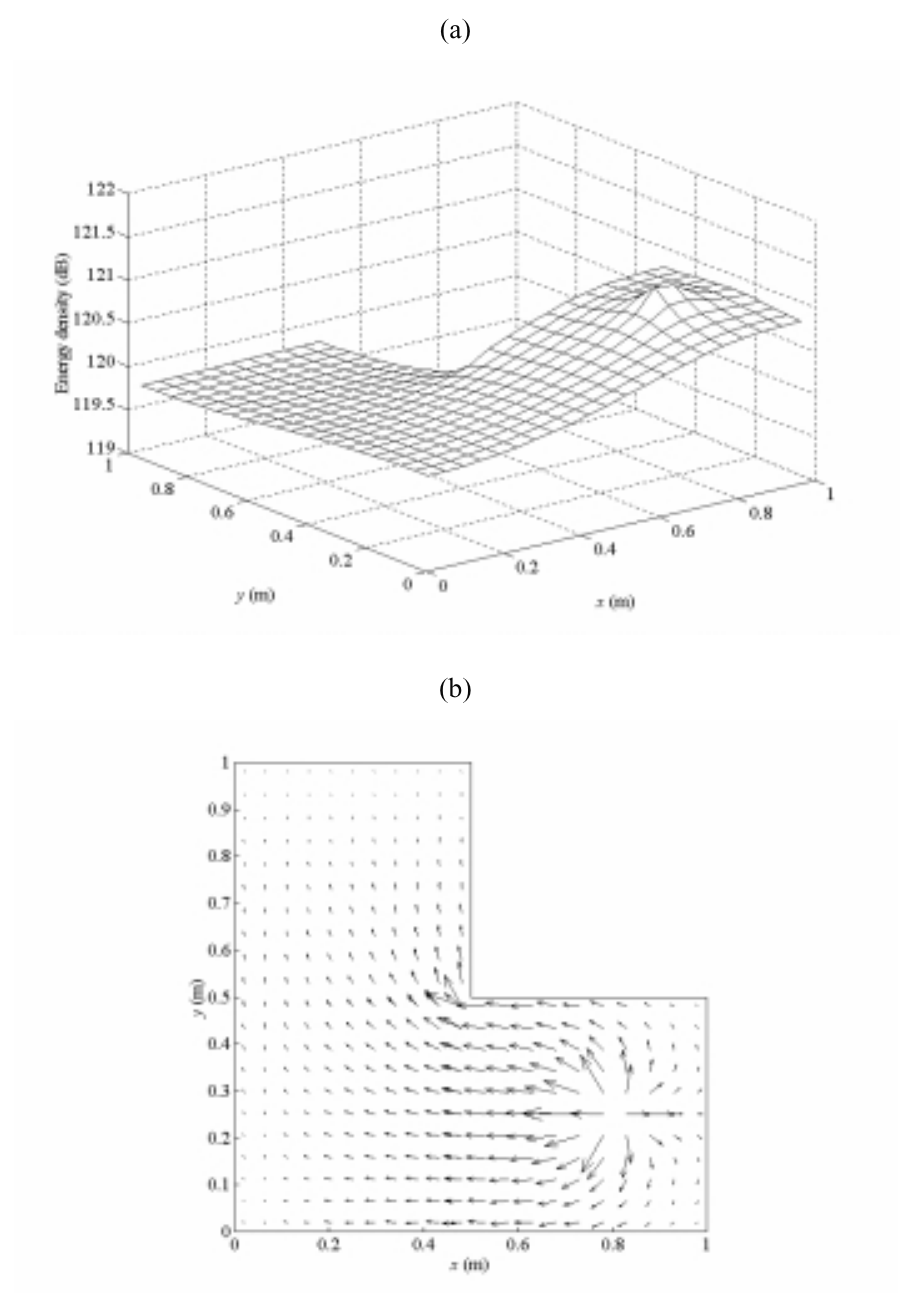
Fig. 12. The energy density and intensity distributions in L-shaped plate predicted by direct EFBEM when f = 1 kHz and η = 0 . 02 . The reference energy density is 1 × 10 − 12 J/m 2 ; (a) energy density, (b)